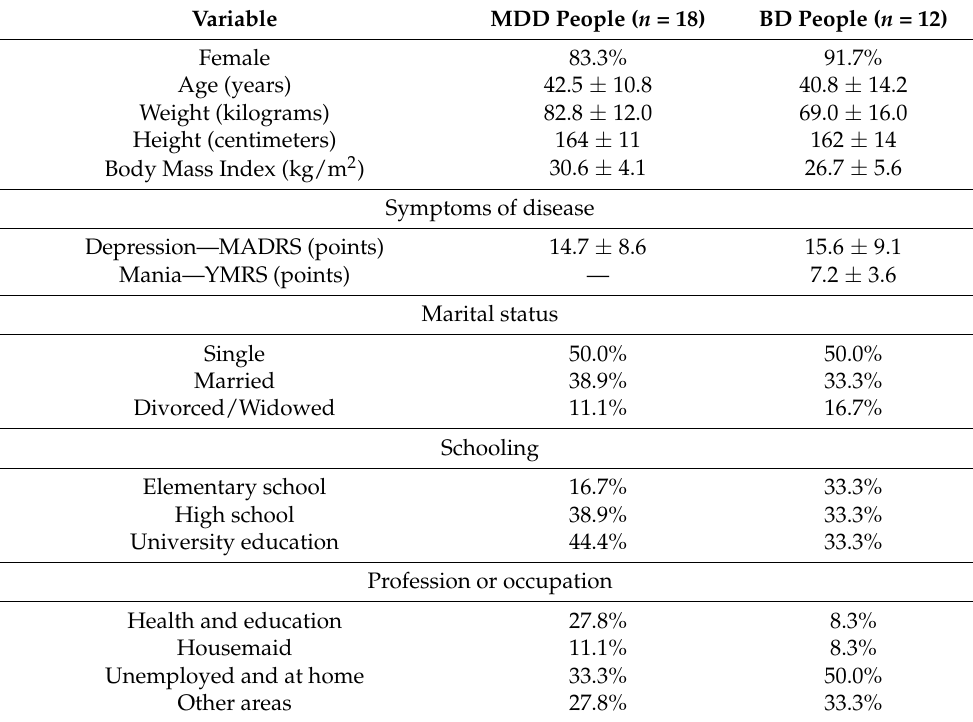
Table 1. Sample characteristics.